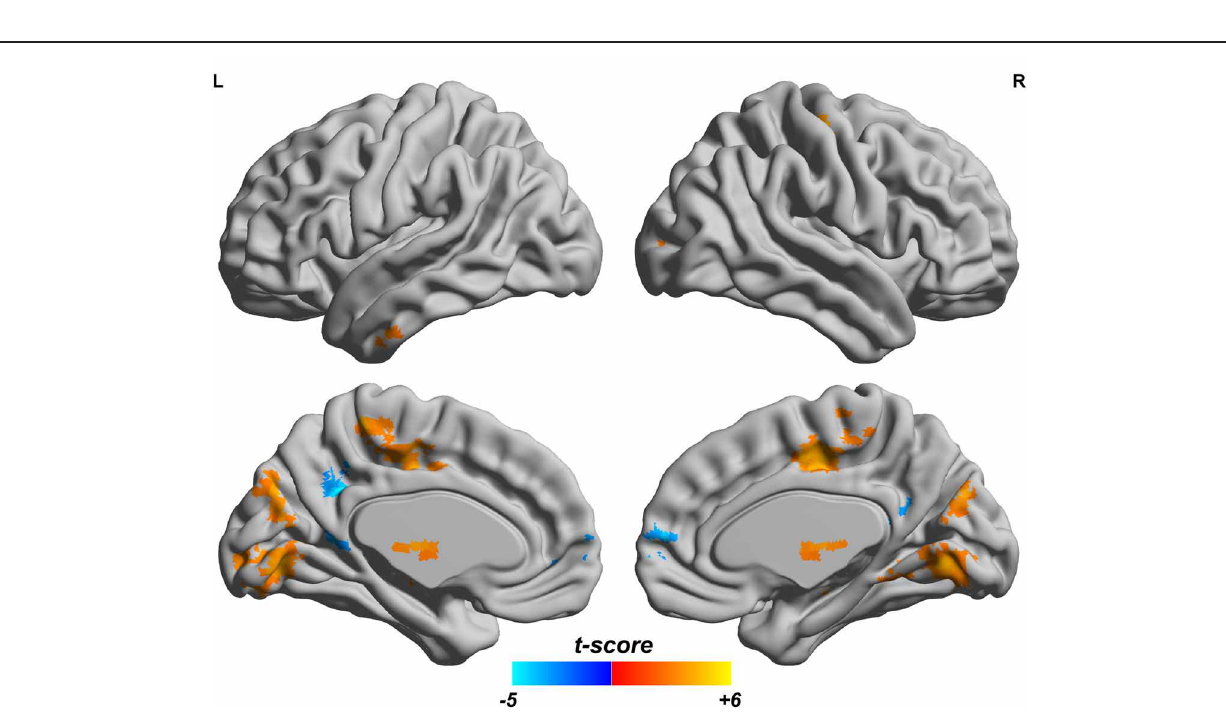
Frontiers in Systems Neuroscience